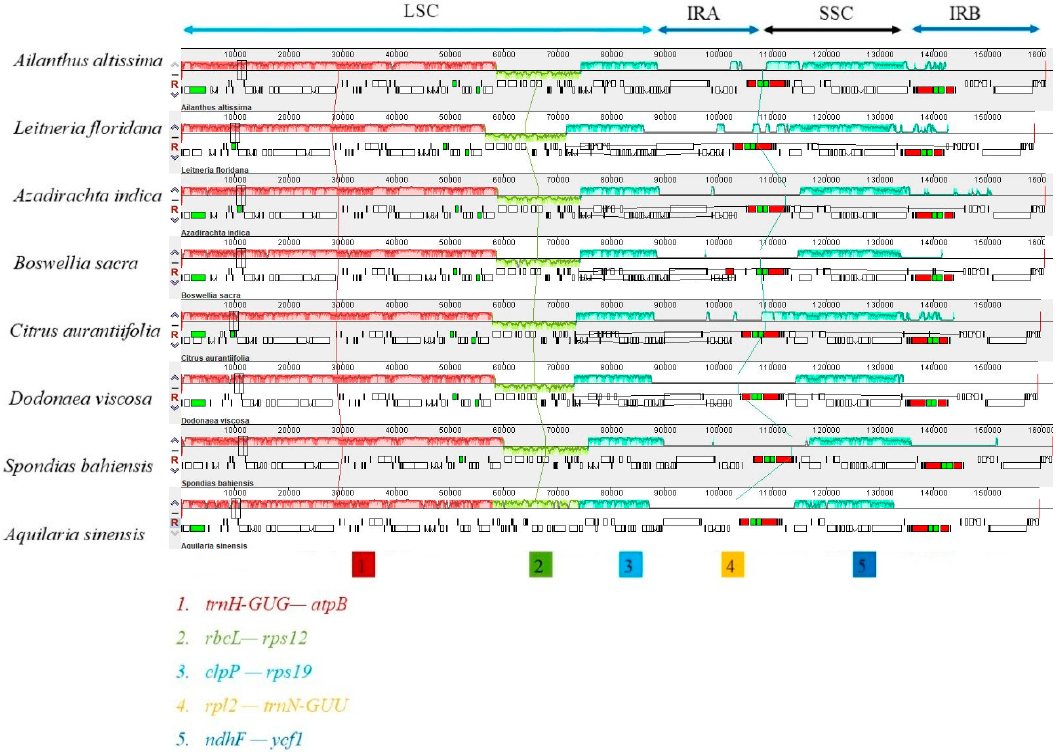
Figure 3. Gene arrangement map of seven chloroplast genomes representing families from Sapindales, and one reference species ( Aquilaria sinensis ) aligned using Mauve software Local collinear blocks within each alignment are represented in as blocks of similar color connected with lines. Annotations of rRNA, protein coding and tRNA genes are shown in red, white and green boxes respectively.